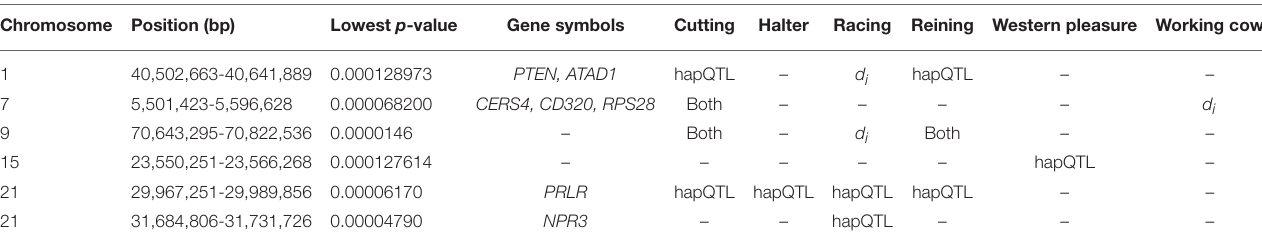
TABLE 4 | ROI identified by hapFLK and their overlap with ROI identified by d i and hapQTL. Chromosome Position (bp) Lowest p -value Gene symbols Cutting Halter Racing Reining Western pleasure Working